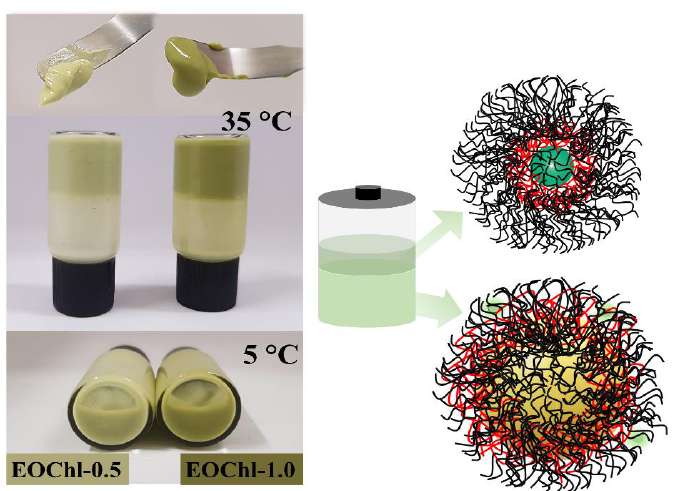
Figure 3. Image of emulgel system at 5 °C and 35 °C and the phase separation representation with micellar dynamics.